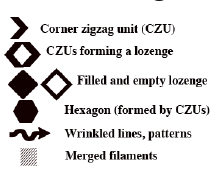
Figure 1. Guidelines signs to spot the peculiar features within the described